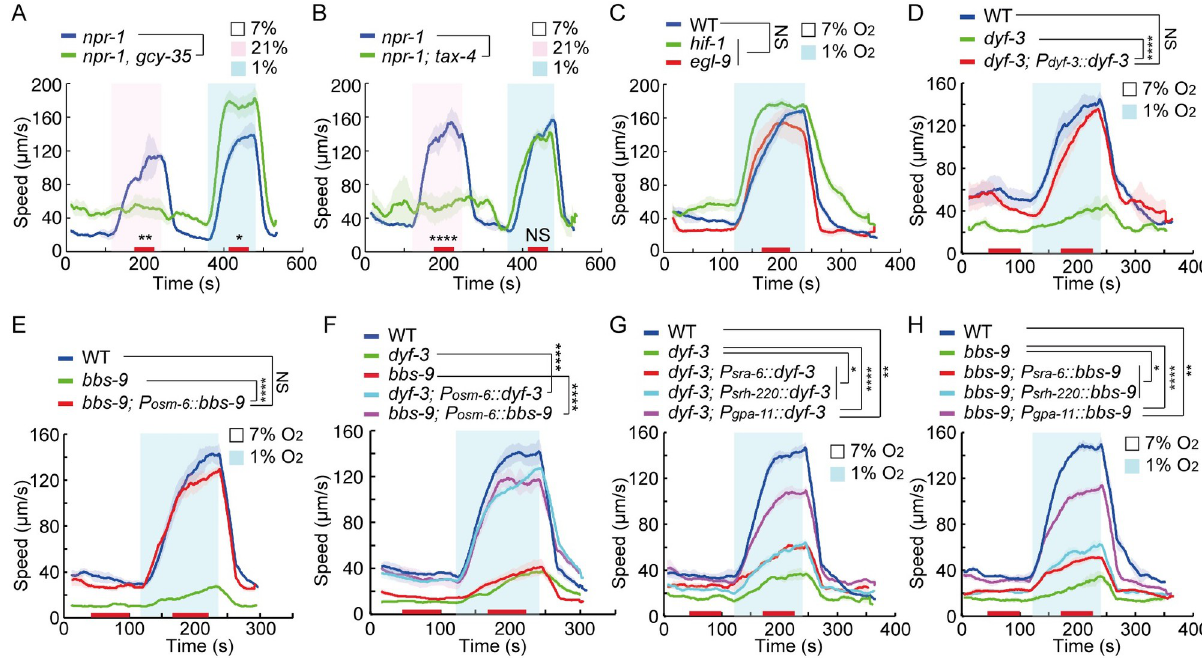
Fig 1. Defects in IFT disrupt escape from hypoxia. (A and B) Locomotory responses to switches from 7% to 21% O 2 and 7% to 1% O 2 of animals of indicated genotype: npr-1(ad609) and npr-1(ad609); gcy-35(ok769) in (A) and npr-1(ad609) and npr-1(ad609); tax-4(p678) in (B). In this and subsequent figures, speed was recorded for 2 minutes at each O 2 interval. Red bars on the x-axis indicate time intervals used for statistical analysis. Data for each genotype are from 3 to 4 assays, > 80 animals. ���� = p < 0.0001, �� = p < 0.01, � = p < 0.05, NS = not significant, Mann–Whitney U test. (C) Locomotory responses to 7% to 1% O 2 stimuli for animals of the indicated genotype: WT (N2), hif-1(ia4) , and egl-9(sa307) animals. NS = not significant. ANOVA, Tukey multiple comparison. (D) Locomotory responses to 7% to 1% O 2 stimuli for animals of the indicated genotype: WT,